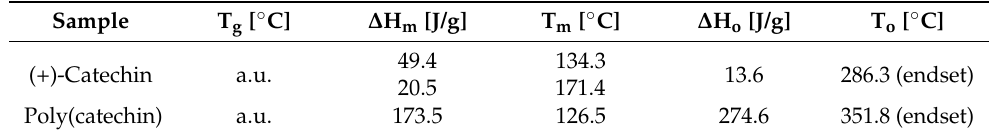
Table 1. DSC analysis of (+)-catechin and